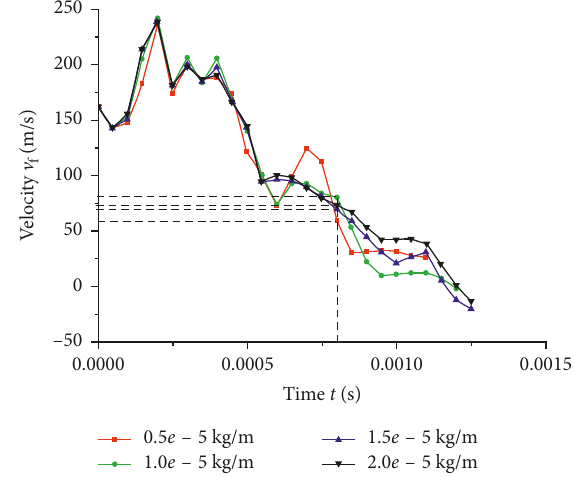
Figure 12: Airflow velocity at the position of fiber end A.